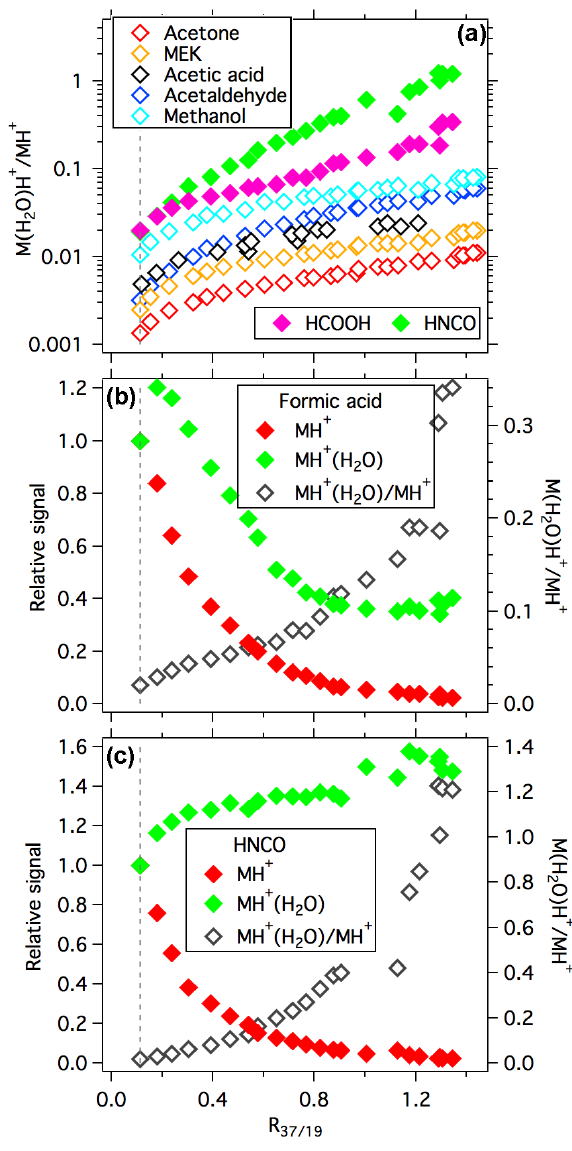
Figure 7. (a) The ratios of hydrated ions to protonated ions for sev- eral OVOC species as a function of R 37 / 19 ratios. ( b and c ) Normal- ized signals relative to dry conditions for protonated and hydrated ions of formic acid (HCOOH, b ) and isocyanic acid (HNCO, c ) as a function of R 37 / 19 ratios. The ratios of hydrated ions to proto- nated ions for formic acid and isocyanic acid vs. R 37 / 19 ratios are also shown in (b) and (c) , respectively. Vertical dashed lines in each panel indicate the level of R 37 / 19 under dry